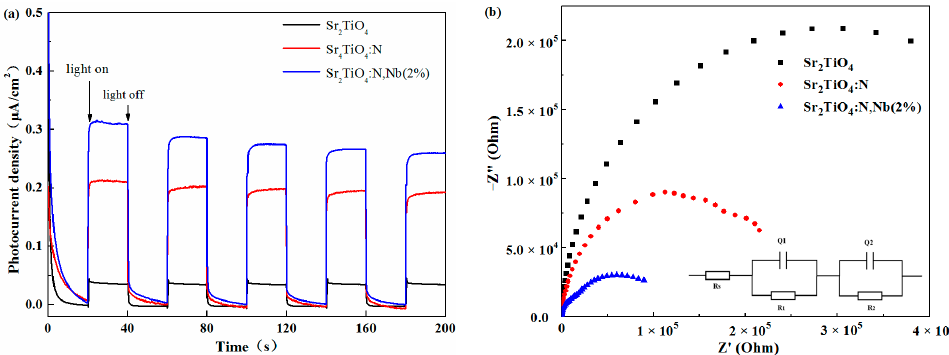
Figure 7. Photocurrent response ( a ) and EIS diagram ( b ) of Sr 2 TiO 4 , Sr 2 TiO 4 :N, and Sr 2 TiO 4 :N,Nb(2%), inset shows the equivalent circuit.